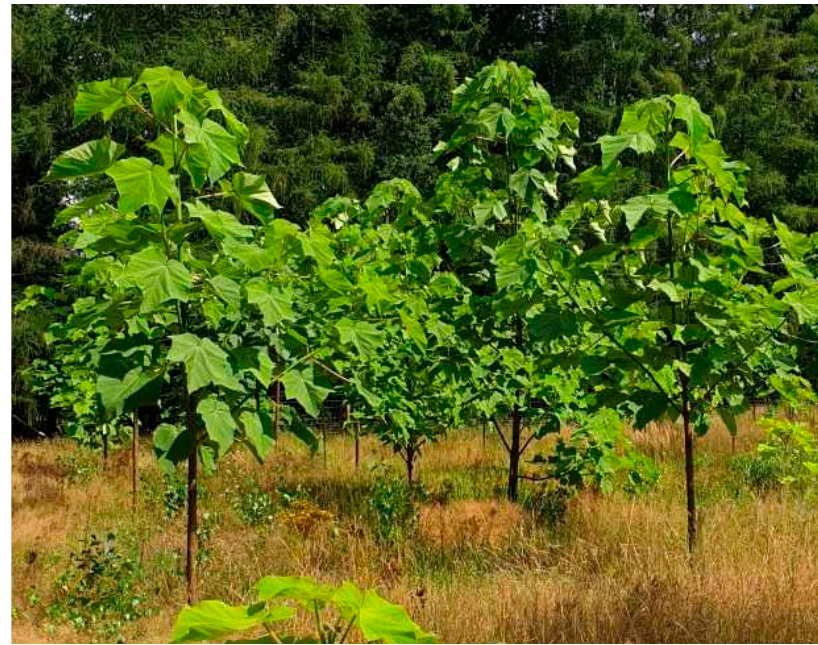
Figure 1. Overview of the plantation.